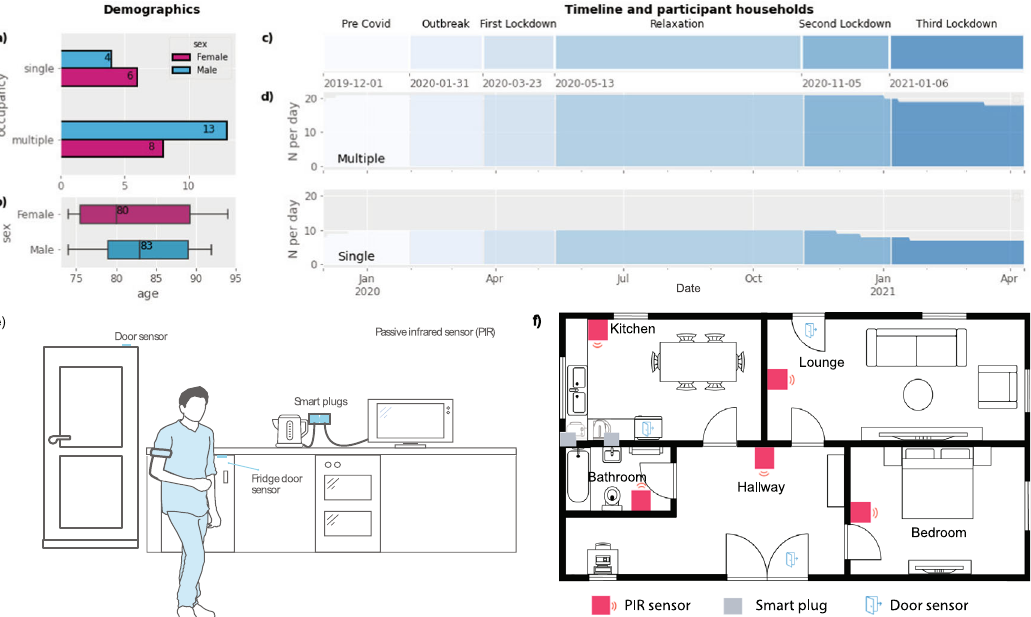
Fig. 1 Cohort description and home monitoring system. a , b Household occupancy, sex and age distributions (boxplot shows the minima and maxima values, lower and upper quartiles, and the medians); c Timeline for data collection over the COVID-19 pandemic; d Number of participant households throughout the study; e Sensors contributing to the data reported in this study: passive infra-red movement sensors on the wall and door, as well as smart plugs to monitor household appliance use; f typical layout of sensors in exemplar